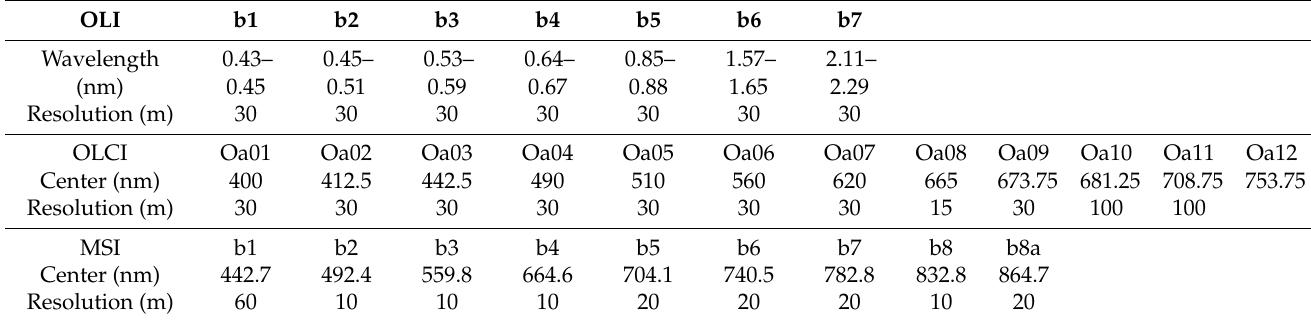
Table A2. Summary of the bands used in this study.